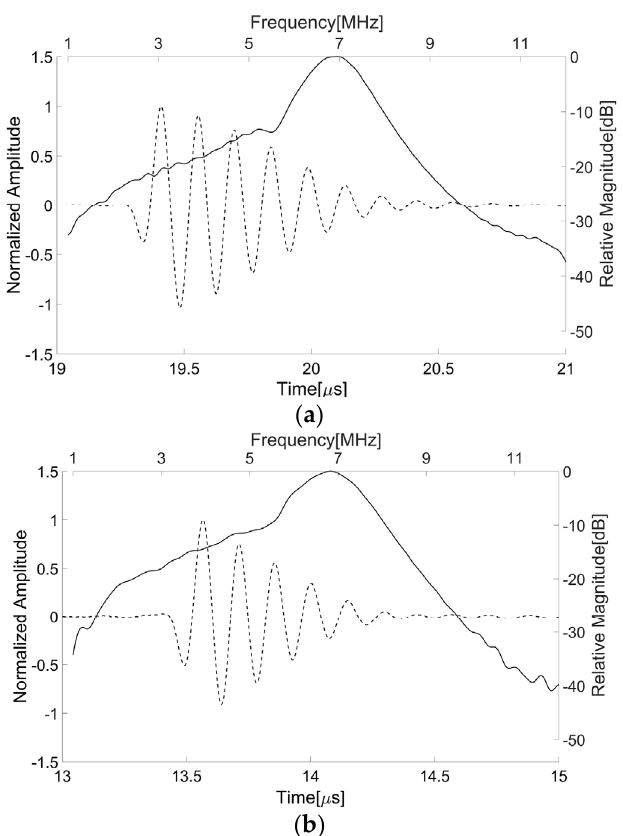
Figure 8. Pulse-echo waveforms and their spectra measured from the press-focused transducer before the lens casting process ( a ) and the double-focused transducer fabricated in this study ( b ). The solid line indicates the magnitude of the spectrum and the dotted line is the pulse-echo waveform.